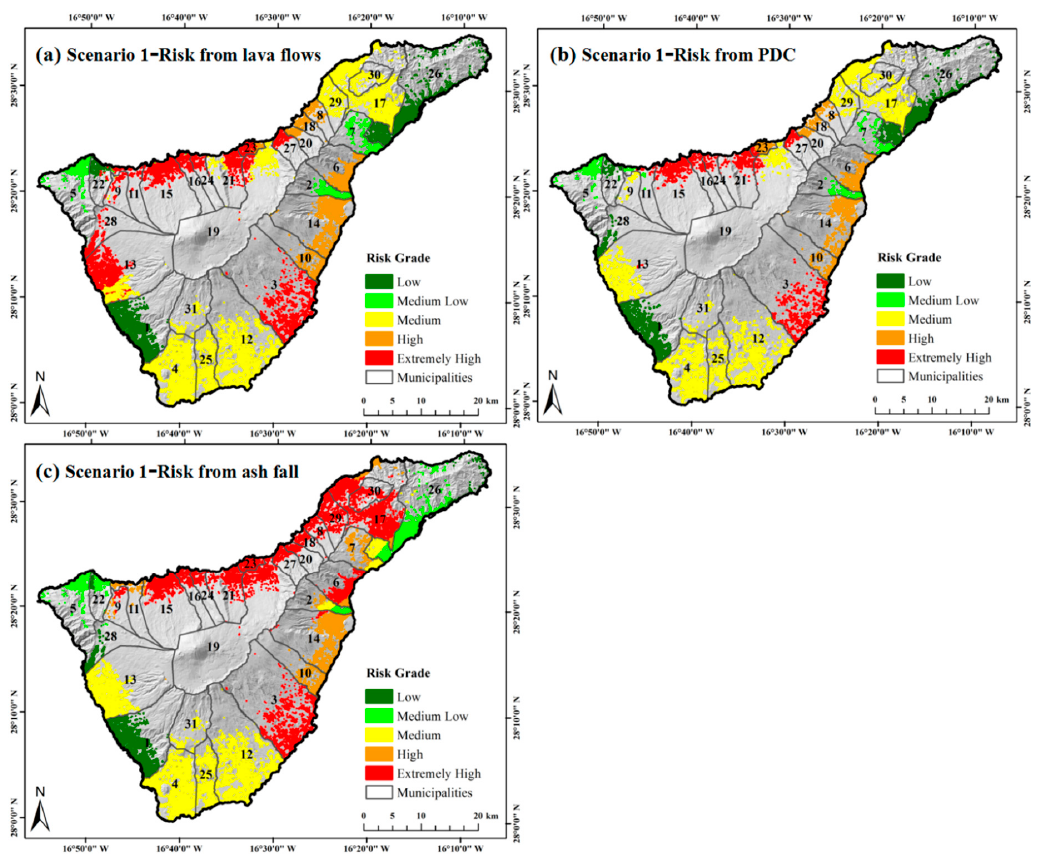
Figure 13. Volcanic risk grading map of Tenerife in Scenario 1. ( a ) Risk from lava flows. ( b ) Risk from PDC. ( c ) Risk from ash fall.